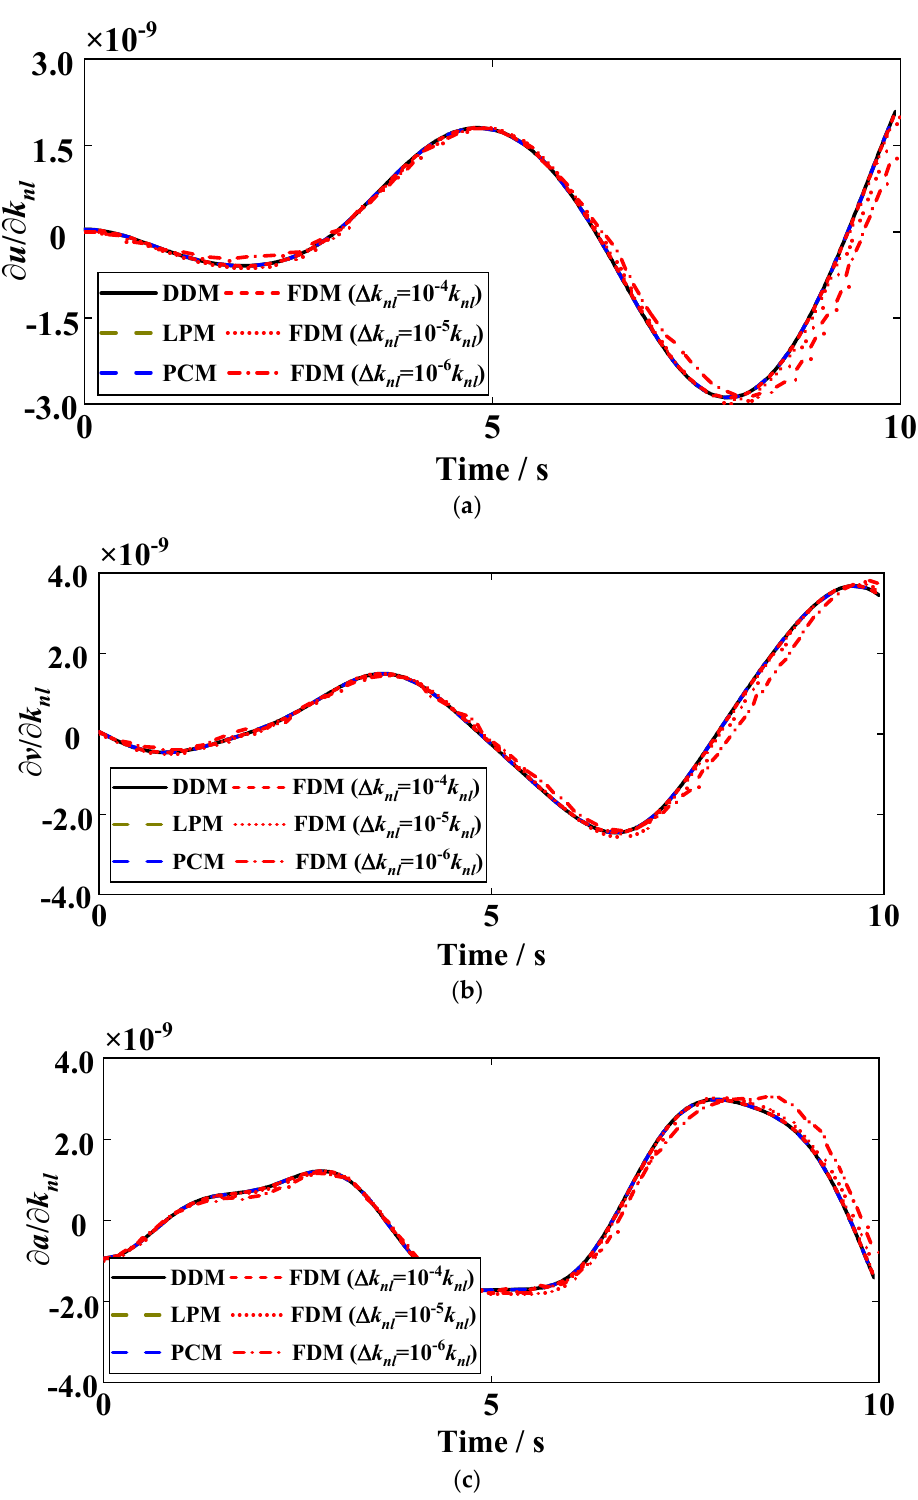
Figure 2. Sensitivities of ( a ) displacement, ( b ) velocity, and ( c ) acceleration with respect to the nonlinear stiffness k nl in different perturbations ( 0 u = 1 mm).